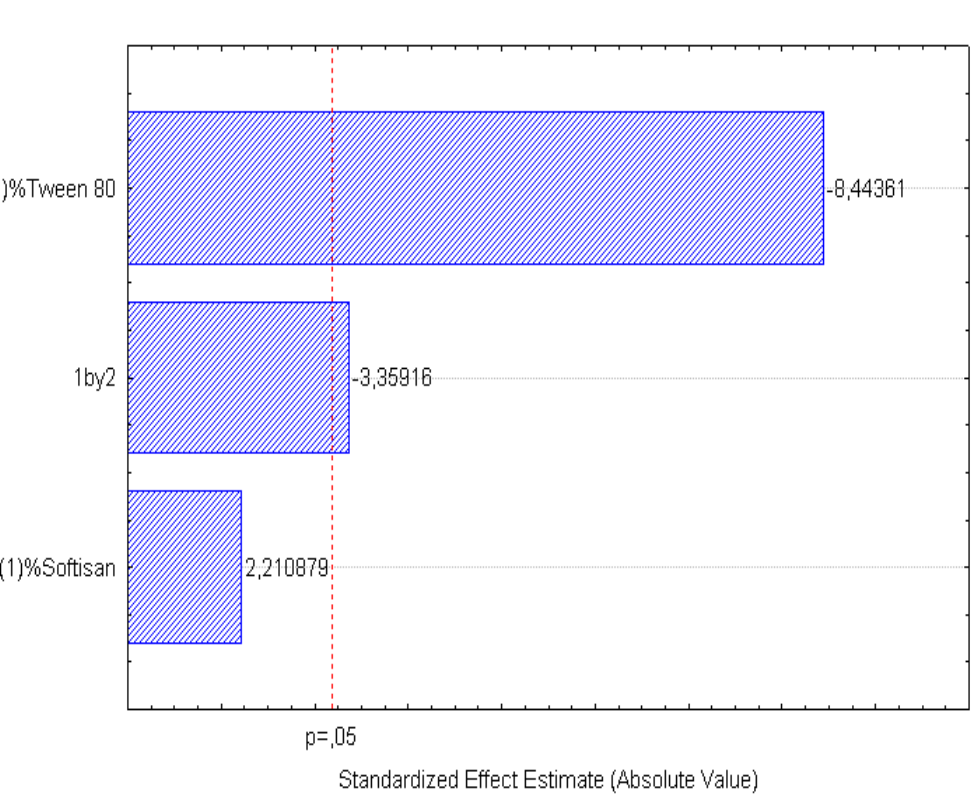
Figure 3. Surface response chart of the effect of the % of Tween ® 80 and SOFTISAN ® 649 on z-Ave.